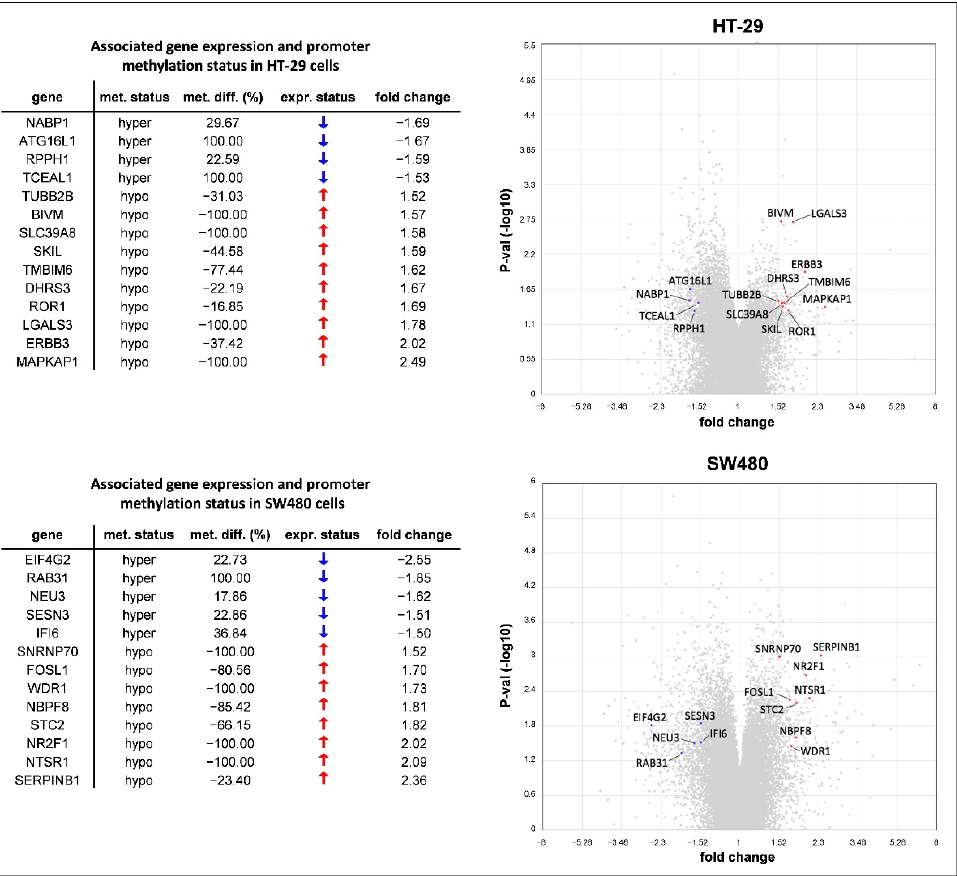
Figure 5. The intersection of genome-wide DNA methylation and gene expression data obtained by Reduced Representation Bisulfite Sequencing (RRBS) and Human Transcriptome Array (HTA) 2.0 analyses. Values represent the methylome and transcriptome pattern changes of 10,000 ng/mL folic acid (FA)-treated HT-29 and SW480 cells compared to non-treated samples (0 ng/mL FA). Only genes with promoter methylation status alteration in accordance with their expression level ( p ≤ 0.05 and fold change ≥ |1.5|) were listed (left) and also visualized in volcano plots (right). Gray points represent all the transcripts detected by the microarray, while blue ones highlight down- and red ones show upregulating genes from the list. met. status: DNA methylation status; met. diff.: DNA methylation difference; expr. status: gene expression status; P-val: p -value.